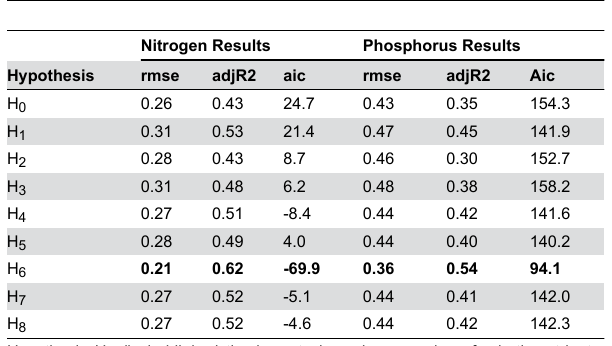
Table 3. T-test of residual means by hydraulic residence time for each